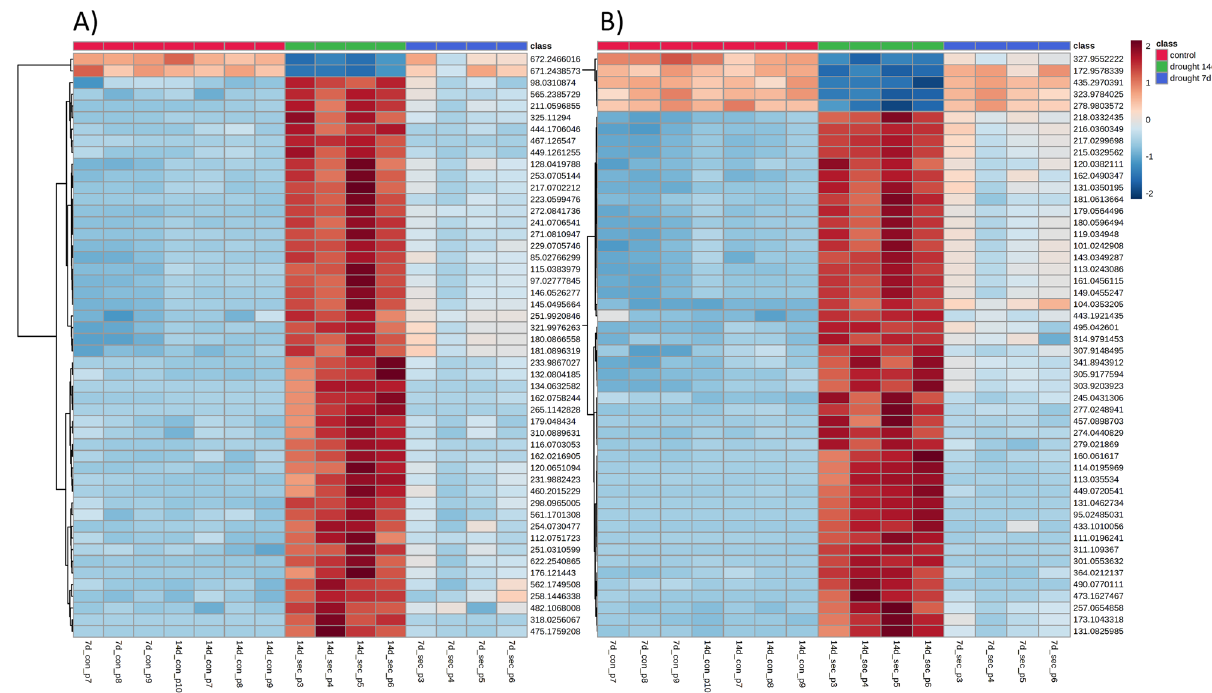
Figure 3. Heatmap analysis. Blue color indicates low intensity and red color indicates high intensity after the applied drought stress. The upper row represent sample groups, red: control group; green: 14 days of stress group; blue: 7 days of stress group. Top 50 VIP variables are shown on the right side. ( A ) UHPLC–ESI(+)–MS. ( B ) UHPLC–(−)–MS.